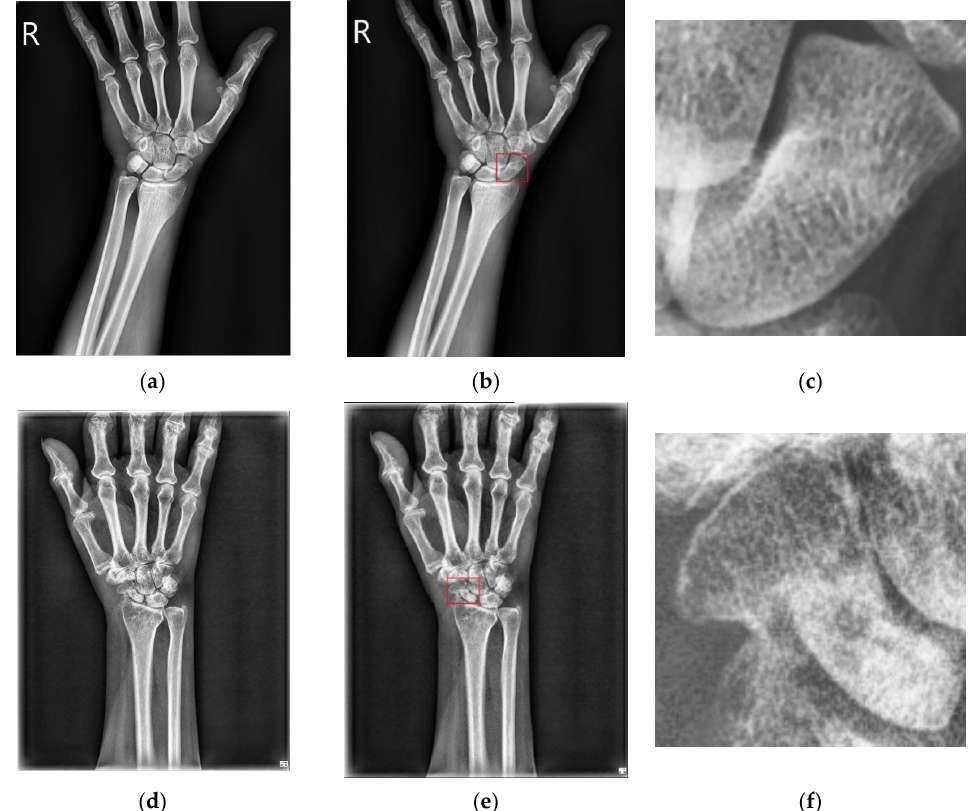
Figure 8. Two image samples with and without fractures. ( a ) Normal case. ( b ) Scaphoid area marked red of ( a ). ( c ) Enlarged scaphoid area of ( b ). ( d ) Fractured case. ( e ) Scaphoid area of ( a ). ( f ) Enlarged scaphoid area of ( b ).